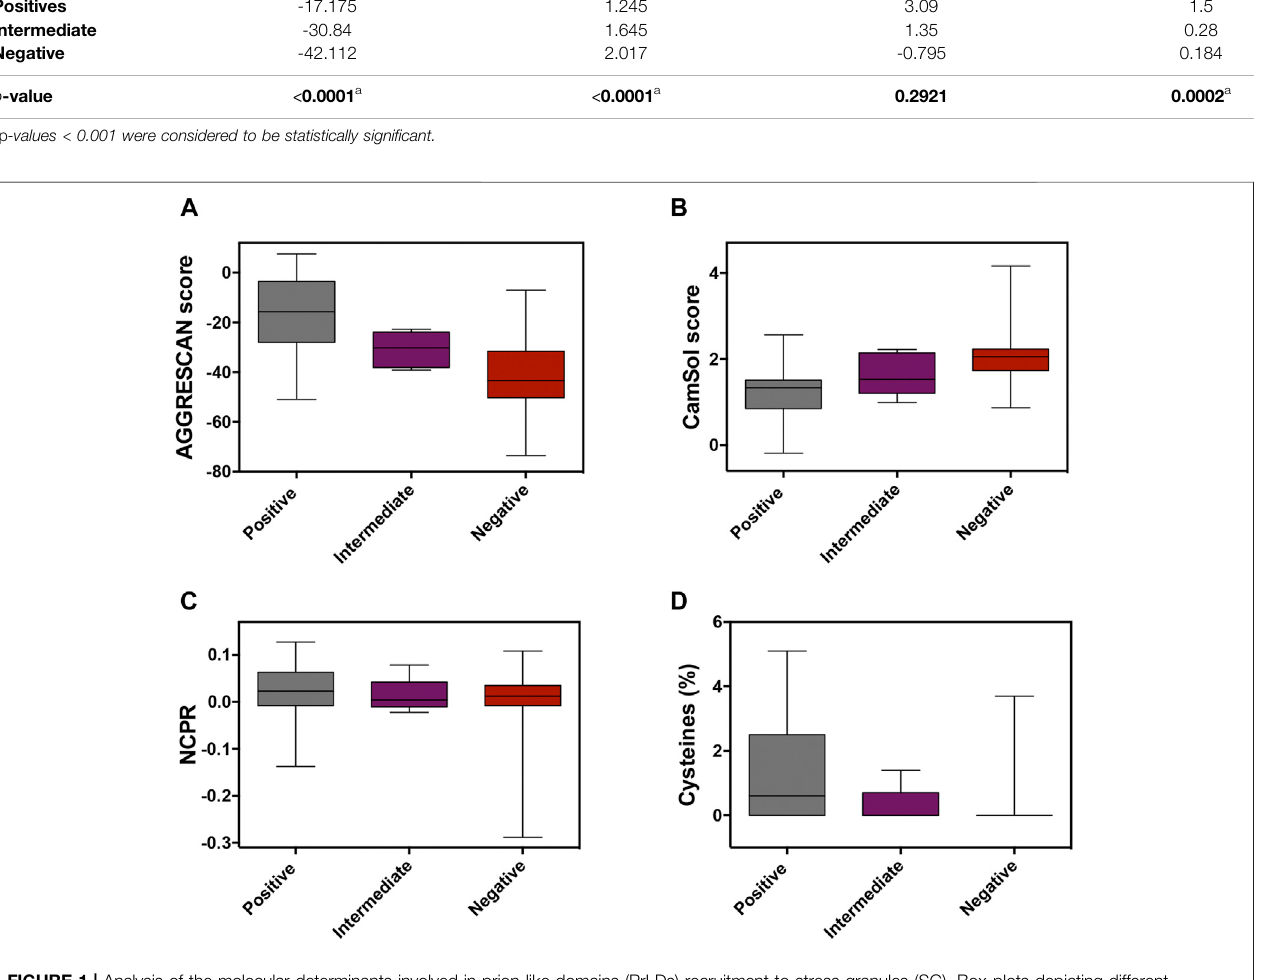
FIGURE 1 | Analysis of the molecular determinants involved in prion-like domains (PrLDs) recruitment to stress granules (SG). Box-plots depicting different properties of assembling and non-assembling PrLDs in the complete dataset: protein aggregation using (A) AGGRESCAN and (B) CamSol Intrinsic predictors, (C) the net charge per residue, and (D) the cysteine